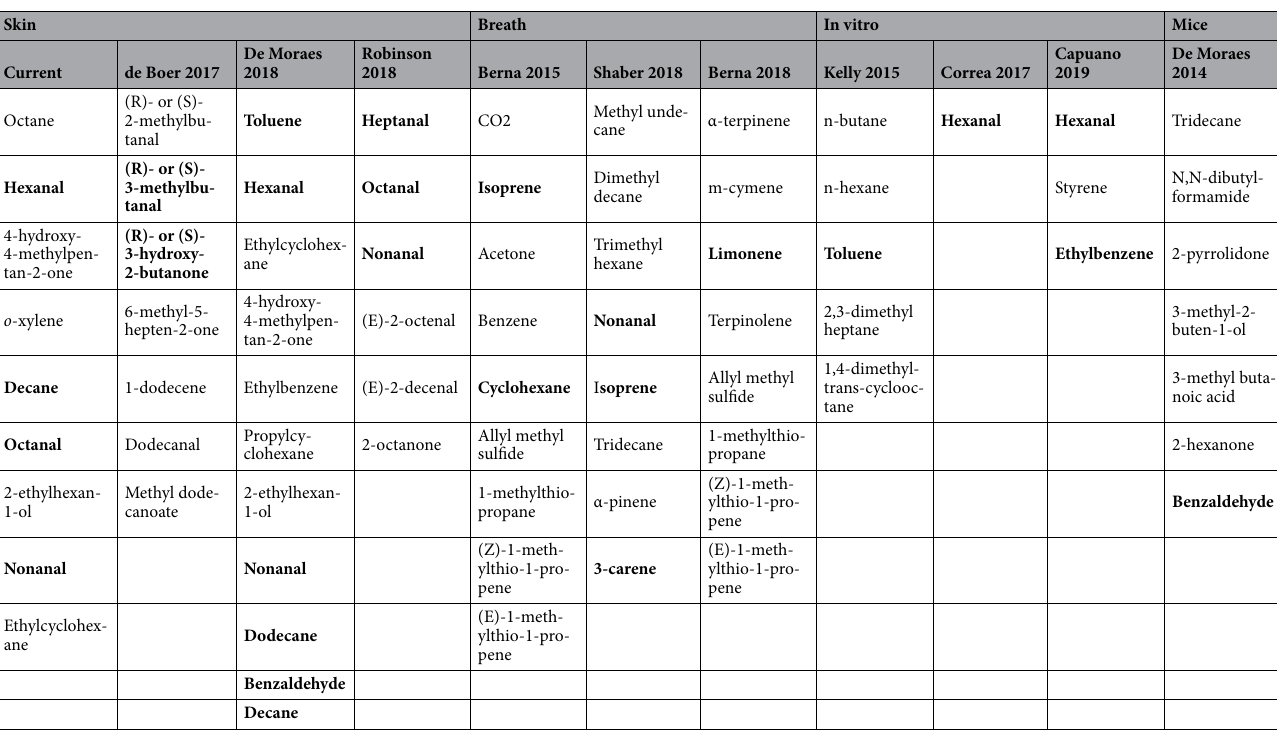
Table 4. Volatiles altered by malaria in previous studies, and other diseases (bold). Lung cancer: hexanal, octanal, nonanal, 3-hydroxy-2-butanone, 3-methyl-butanal (in vitro) 28–30 . Breast cancer: hexanal, heptanal, octanal, nonanal, decane, limonene, cyclohexane 31,32 . Colorectal cancer: nonanal 33 . Prostate: Toluene 34 . Head and neck cancer: isoprene, limonene 35,36 . Pneumonia: nonanal, ethylbenzene, benzaldehyde, 3-methyl-butanal, cyclohexane, dodecane, 3-carene 37–40